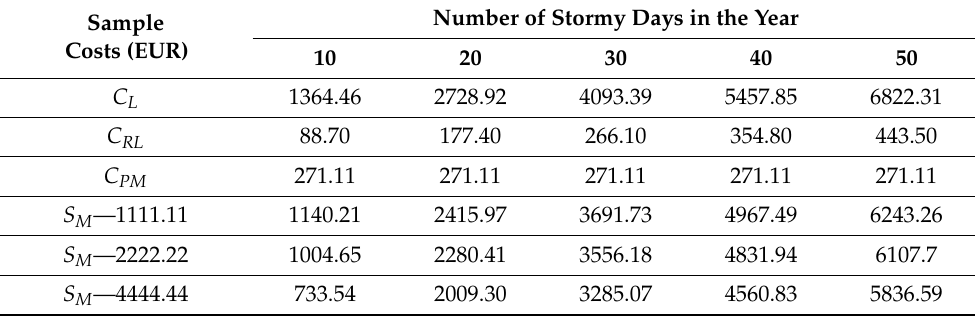
Table 8. Risk R 4 —loss of economic value for the different numbers of stormy days in the year.